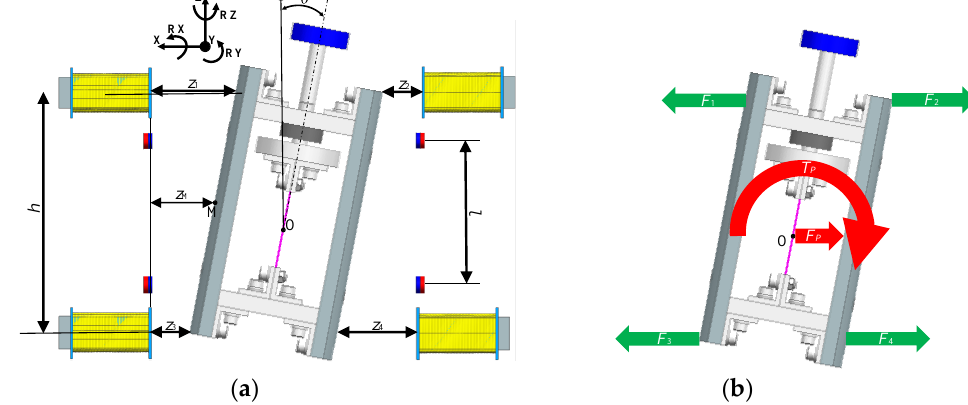
Figure 6. Illustration of the plant model: ( a ) Illustration of the dimensions ( b ) Illustration of the forces.